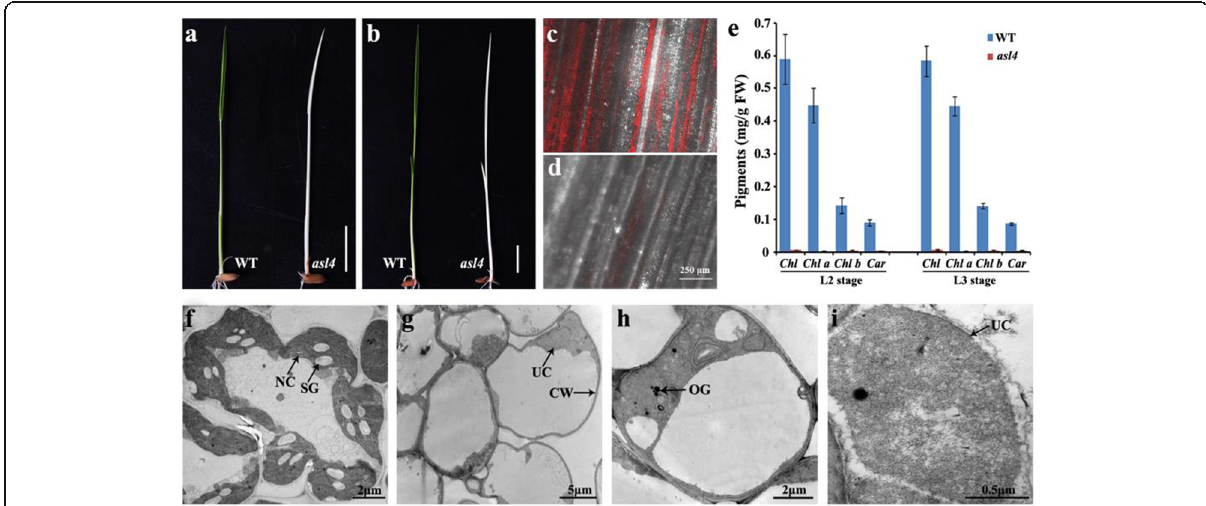
Fig. 1 Phenotypic characteristics of the asl4 mutant. a Phenotype of wild type and the asl4 mutant at the L2 stage grown in the field. b Phenotype of wild type and the asl4 mutant at the L3 stage. Confocal microscope observation of chlorophyll-containing cells in seedlings of wild type ( c ) and the asl4 mutant ( d ). e Photosynthetic pigment determination in seedlings of wild type and asl4 mutant at the L2 and L3 stages. Values are means ± SD from three independent replicates. TEM observations of chloroplasts in wild type ( f ) and asl4 ( g - i ) seedlings at the L3 stage. NC normal chloroplast, SG starch granule, UC undifferentiated chloroplast, CW cell wall, OG osmiophilic